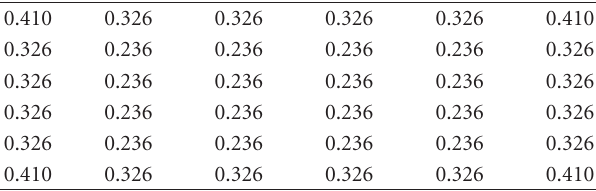
Table 3: k -factors for the simple spacer.